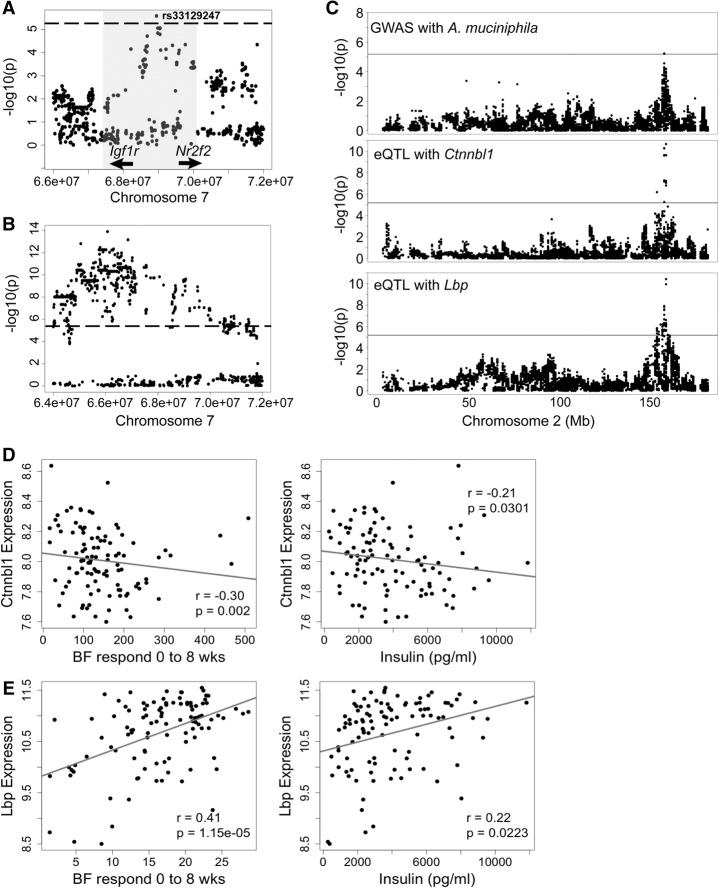
Chromosome 2 and 7 loci for abundance of A. muciniphila. (A) Locus plot for genome-wide significant association of A. muciniphila abundance to a Chromosome 7 locus, indicating the LD block (shaded in gray) and peak SNP rs33129247. Locations of candidate genes are indicated. (B) Locus plot for association with TG (triglyceride) at the Chromosome 7 locus. See also Supplemental Tables 6 and 7. (C) Chromosome 2 locus showing overlapping associations with the abundance of A. muciniphila and cis-eQTLs of the Ctnnbl1 and Lbp genes in adipose. (D) Correlation of epididymal adipose gene expression of Ctnnbl1 with body fat and insulin levels after 8 wk of the HF/HS diet. (E) Correlation of epididymal adipose gene expression of Lbp with body fat response and insulin levels after 8 wk of the HF/HS diet. (BF) Body fat, (r) biweight midcorrelation, (p) P value.